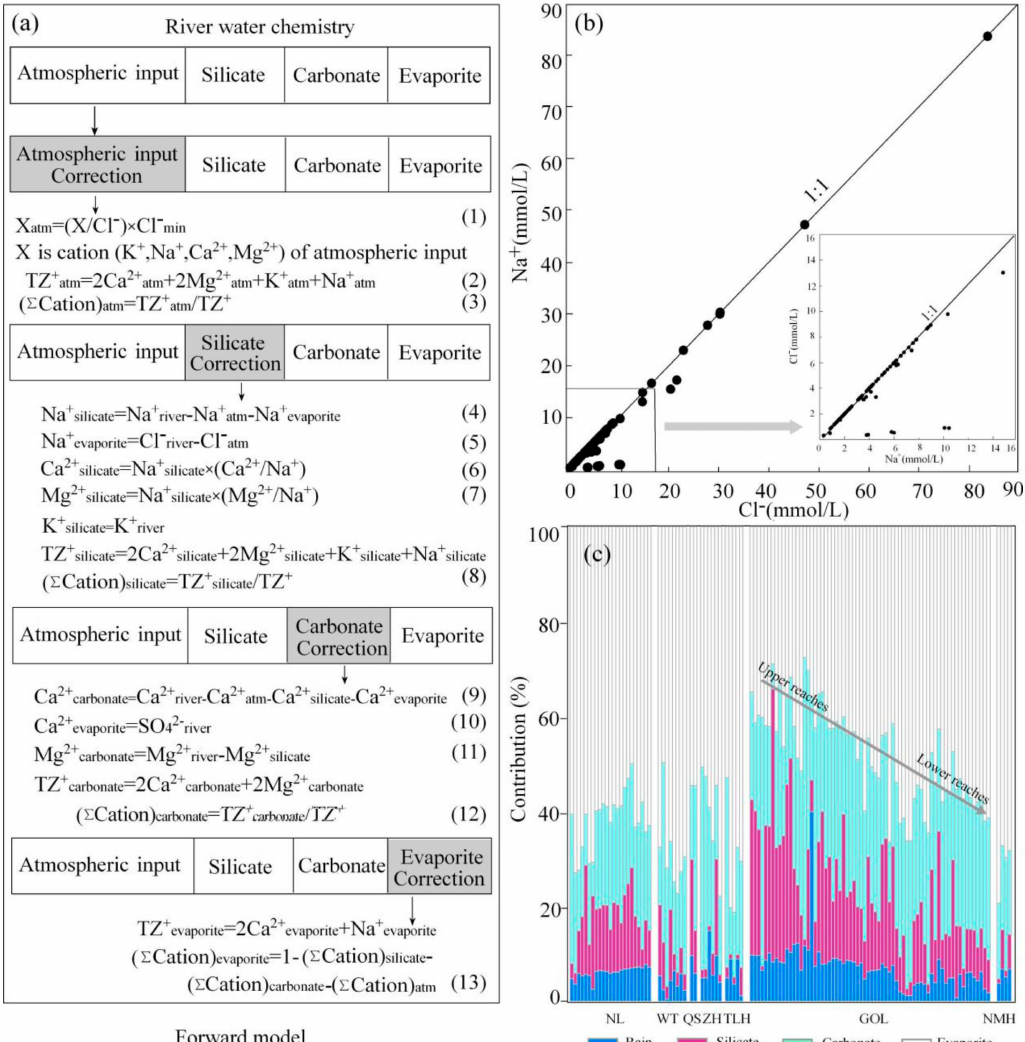
Figure 5. ( a ) An outline of the forward model used to calculate the contributing fractions of the each end–member. ( b ) The relationship between Na + and Cl − that corrected for atmospheric